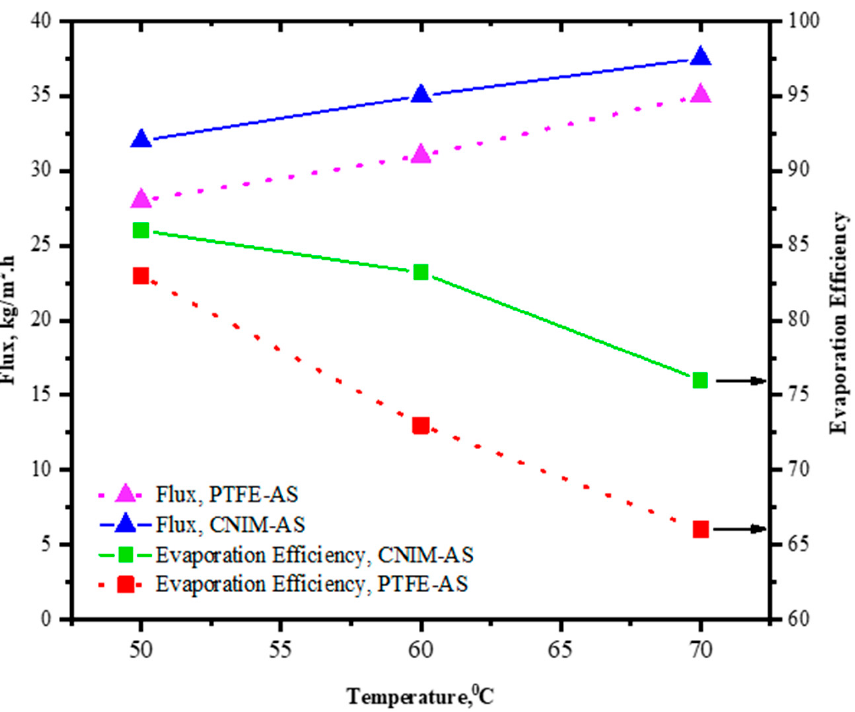
Figure 6. Effect of temperature on flux and evaporation efficiency for HA acid on control PTFE and CNIM.